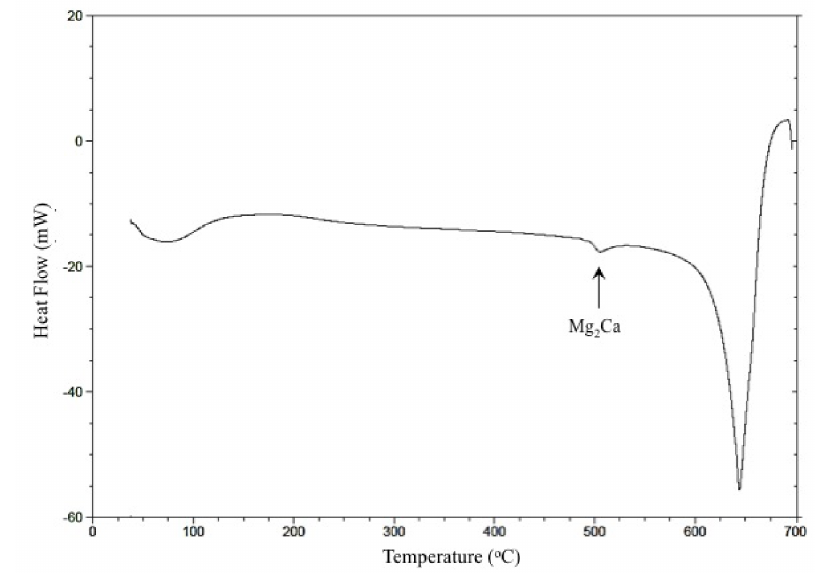
Figure 4. Differential scanning calorimetry (DSC) curve of TX32-0.4Al-0.4Zn (TXAZ3200) alloy in the as-cast